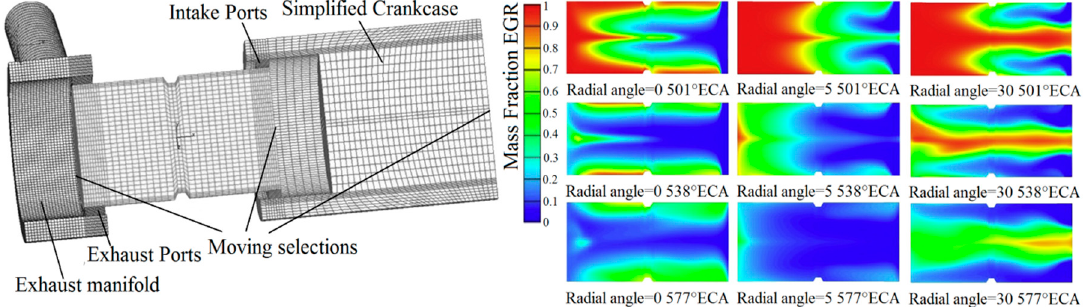
Figure 29. The HFPE 3D simulation model and in-cylinder flow field analysis of Tianjin University [32].